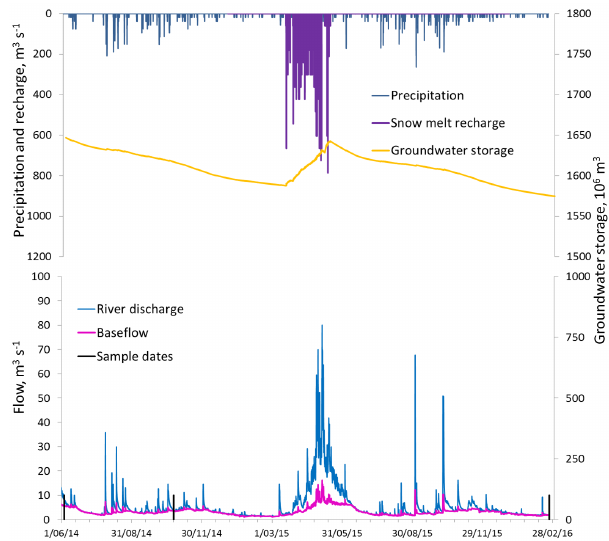
Figure 9. The change of Otarunai groundwater storage estimated using tritium groundwater volume at baseflow. The groundwater storage is recharged by precipitation and snowmelt and is drained by the baseflow component of river